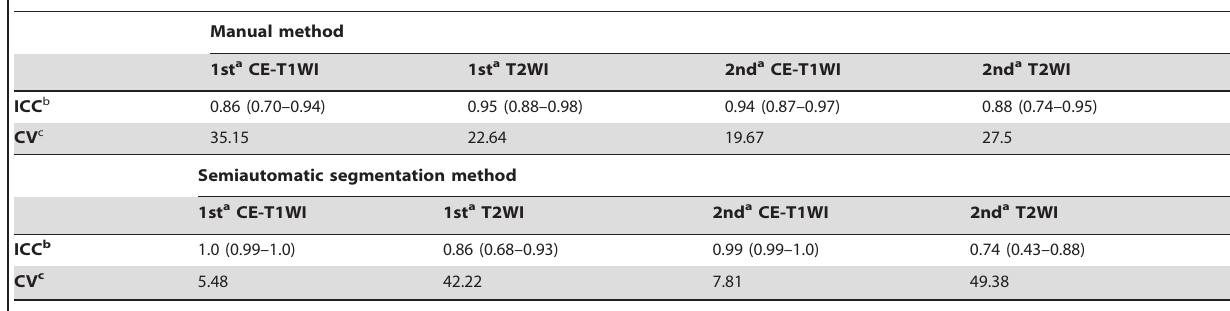
Table 3. Interobserver reproducibility of nCBV